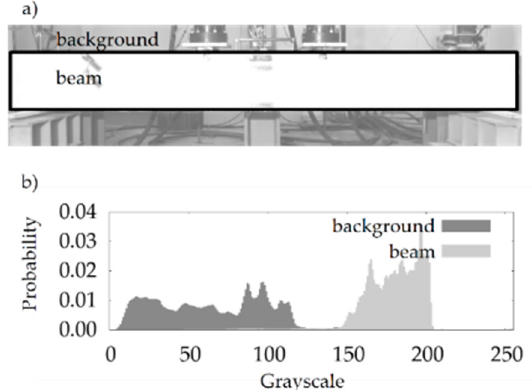
Figure 17. Divergent colour spectrum of the background and side surface of the beam in a grey scale: ( a ) sample photo of beam #1, ( b ) colour spectrum of the photo, with a division into background and beam surface.